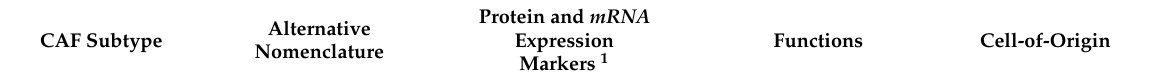
Table 2. Summary of mammalian prostate CAF markers, functions and